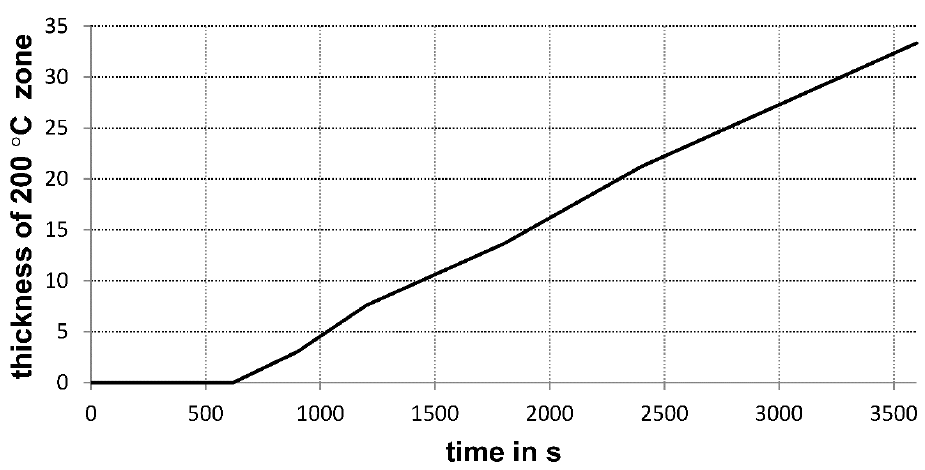
Figure 15. Roof slab (300 mm thick). Time development of the zone where temperature excites 200 ° C.